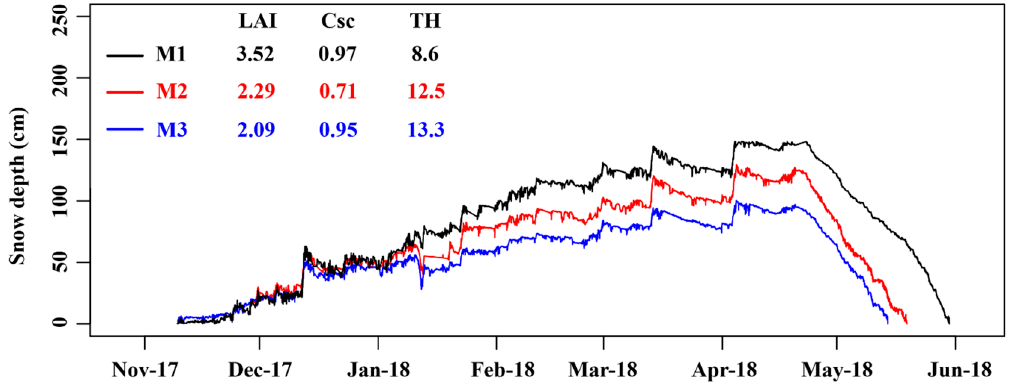
Figure 9. Snow depth recorded at the three mature sites (M1, M2 and M3) during winter 2. The corresponding leaf area index (LAI in m 2 m − 2 ), canopy cover (Csc in fraction), and mean tree height (TH in m) are also provided.